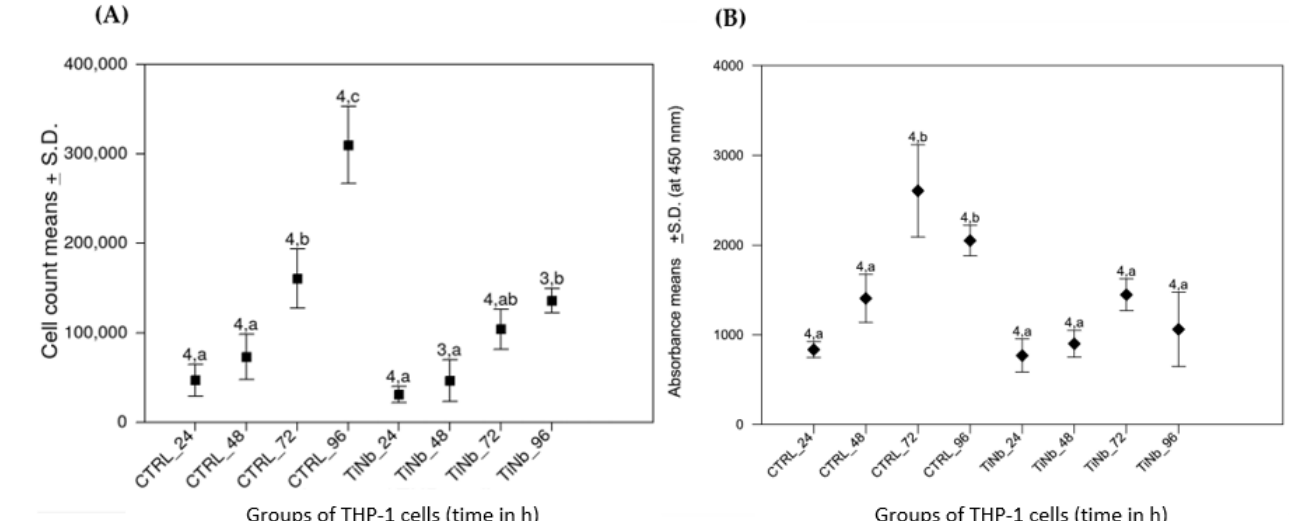
Figure 3. Grown ( A ) and metabolic activity ( B ) of THP-1 cells onto S_TiNb discs compared to CTRL polystyrene surface. The number and the letter displayed onto the bars indicate, respectively, sampling replicates and statistical group. Groups not sharing the same letter are different on the 95% level (Tukey–Kramer method). Absorbance at 450 nm is expressed in mA; ‘CTRL’ and ‘TiNb’ (S_TiNb) groups: growth on polystyrene and smooth TiNb alloy, respectively, for 24, 48, 72 and 96 h.